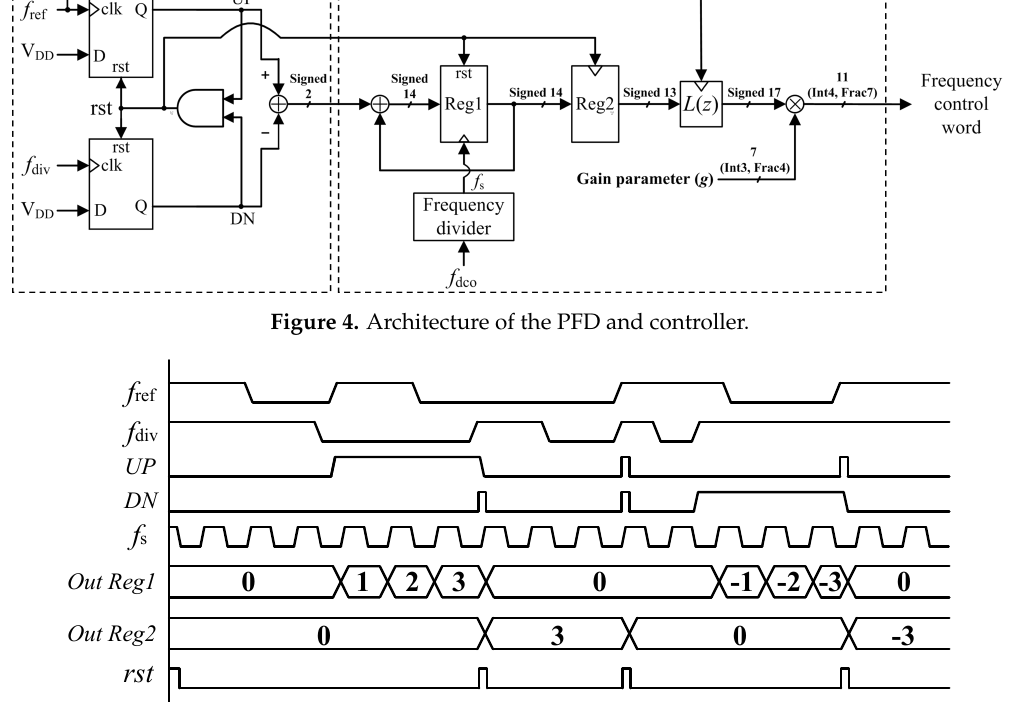
Figure 5. Timing diagram of the PFD and